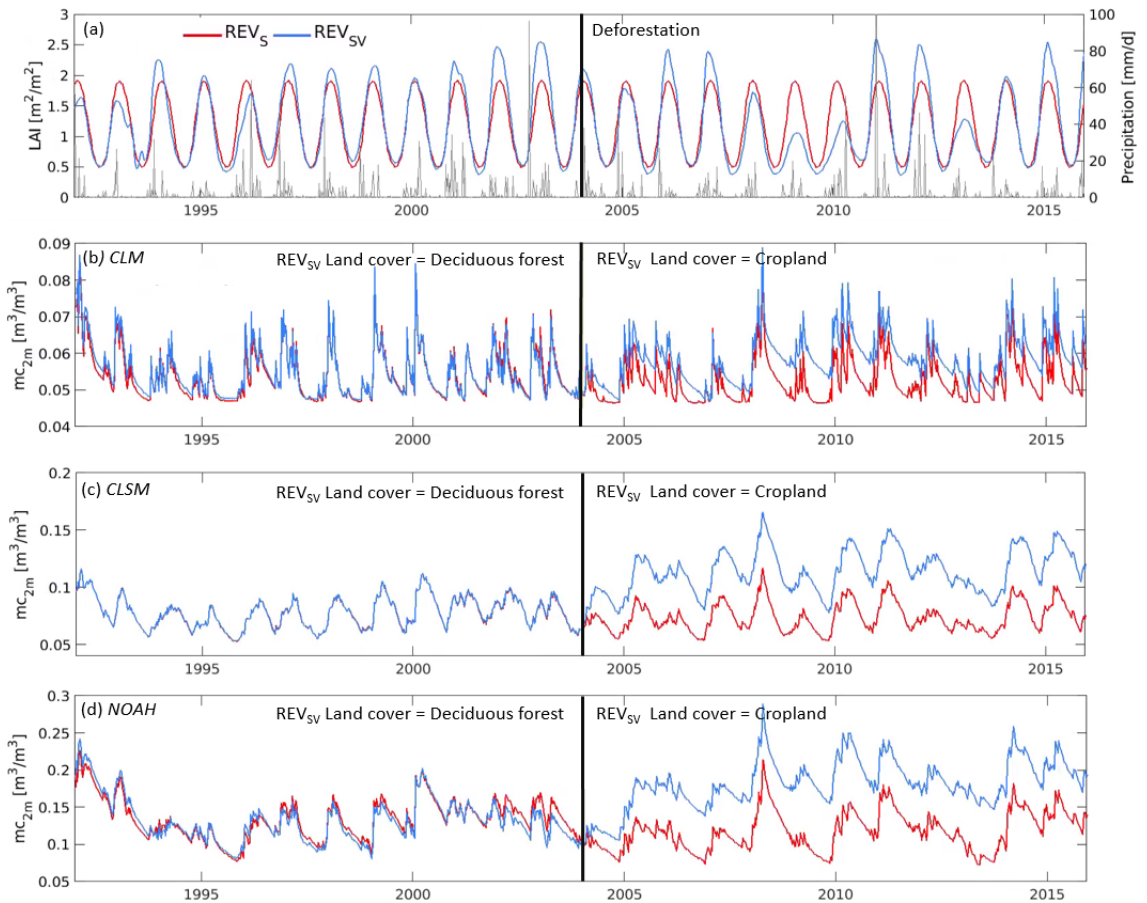
Figure 6. Time series of REV S and REV SV land surface variables for a pixel deforested in 2004 (28.0625 ◦ S, 63.6875 ◦ W): (a) LAI and precipitation; (b, c, d) 2m moisture content (mc 2m ) for CLM, CLSM and NOAH,